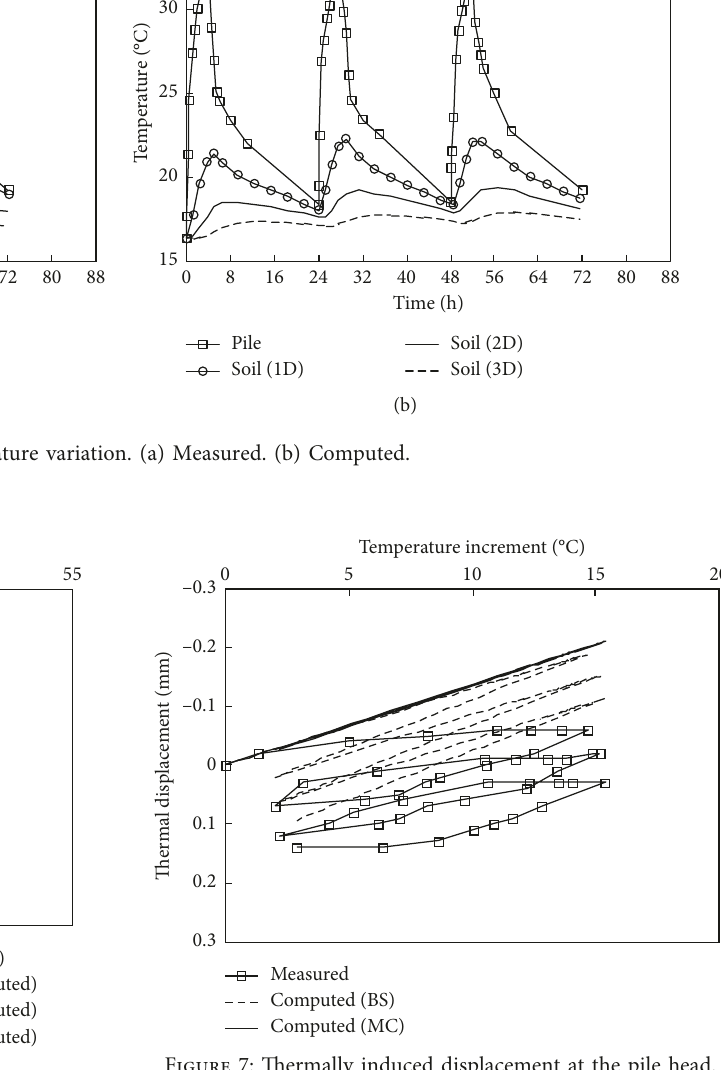
Figure 6: Temperature profiles.